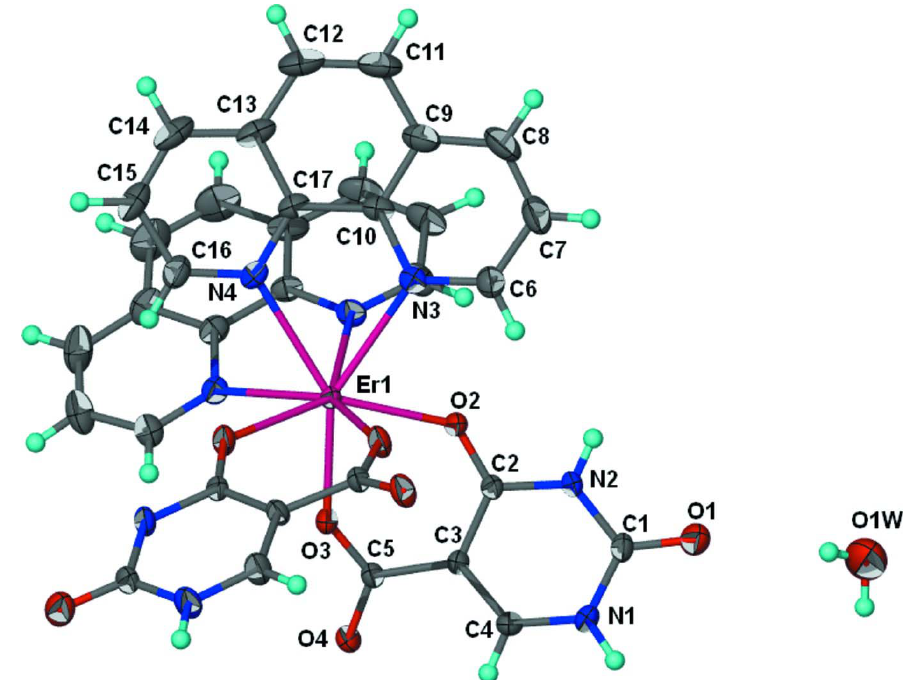
Figure 1 Thermal ellipsoid plot of Er(C are drawn as spheres of arbitrary